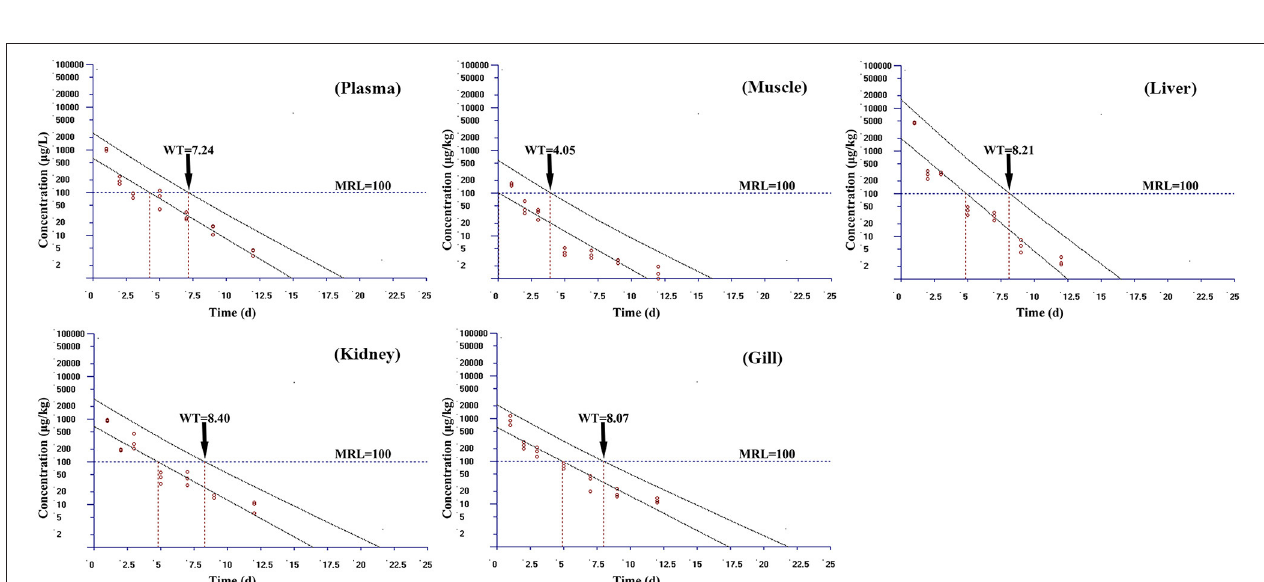
FIGURE 3 | The withdrawal time (WT) of tiamulin in plasma, muscle plus skin, liver, kidney, and gill at 25 ◦ C calculated by WT 1.4 software.